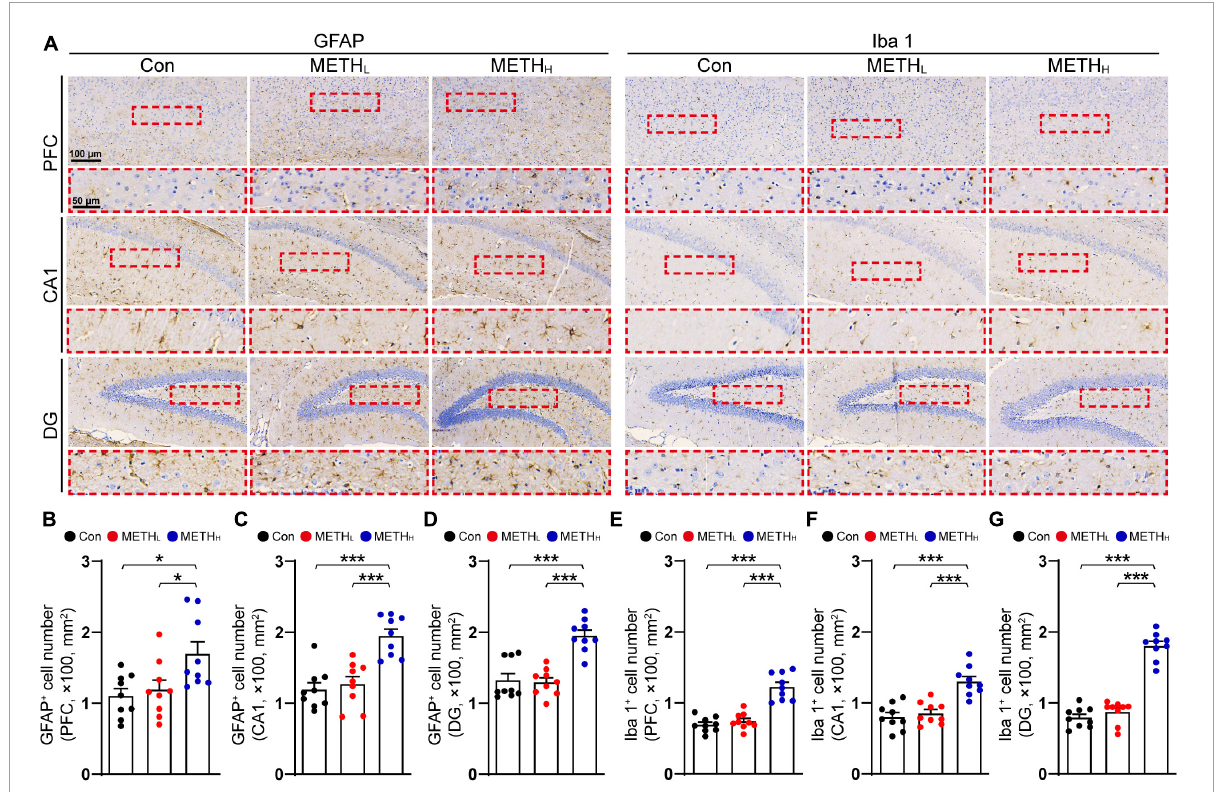
FIGURE4 Effect of low dose and high dose methamphetamine (METH) on glial cell number in cortex and hippocampus. (A) Representative images of GFAP and Iba 1 IHC staining in cortex and hippocampus. (B) Quantification of GFAP + cell density in cortex of control, METH L and METH H mice. One-way ANOVA, F (2, 26) = 5.005, p < 0.05. (C) Quantification of GFAP + cell density in CA1 of control, METH L and METH H mice. One-way ANOVA, F (2, 26) = 18.17, p < 0.001. (D) Quantification of GFAP + cell density in DG of control, METH L and METH H mice. One-way ANOVA, F (2, 26) = 23.114, p < 0.001. (E) Quantification of Iba 1 + cell density in cortex of control, METH L and METH H mice. One-way ANOVA, F (2, 26) = 38.623, p < 0.001. (F) Quantification of Iba 1 + cell density in CA1 of control, METH L and METH H mice. One-way ANOVA, F (2, 26) = 20.342, p < 0.001. (G) Quantification of Iba 1 + cell density in DG of control, METH L and METH H mice. One-way ANOVA, F (2, 26) = 103.087, p < 0.001. n = 9 sections, 3 sections per mouse. * p < 0.05, *** p < 0.001 by one-way ANOVA and Bonferroni’s post hoc